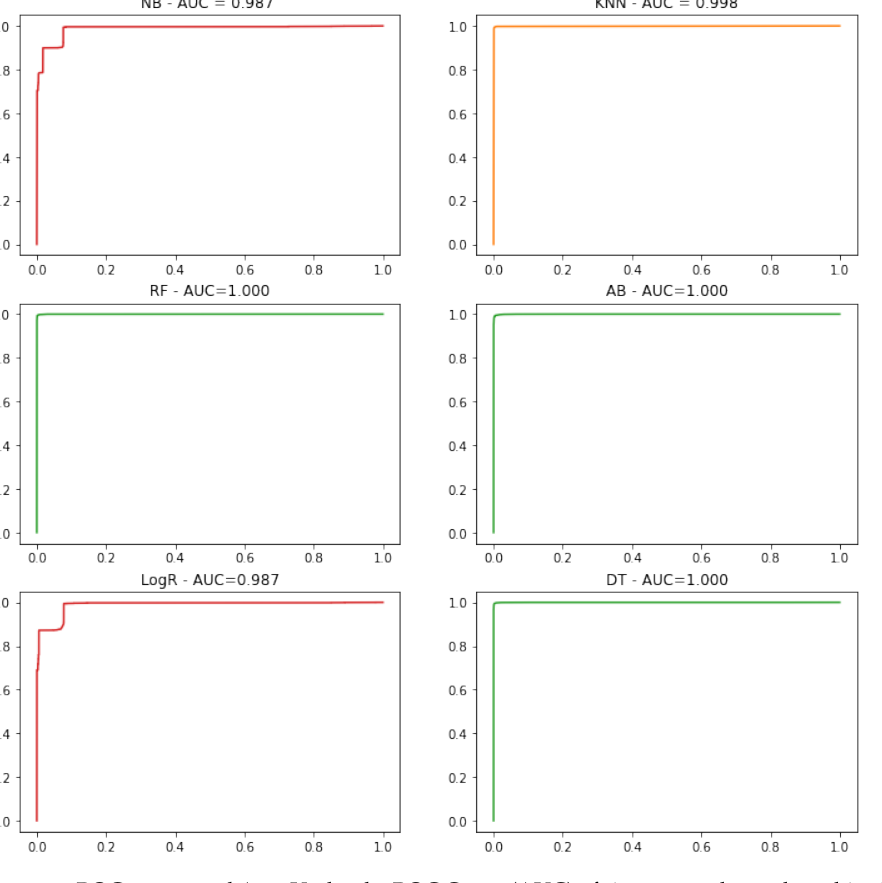
Figure 7. ROC curves and Area Under the ROC Curve (AUC) of six commonly used machine learning classifiers for detecting the malicious in IoT ICU use